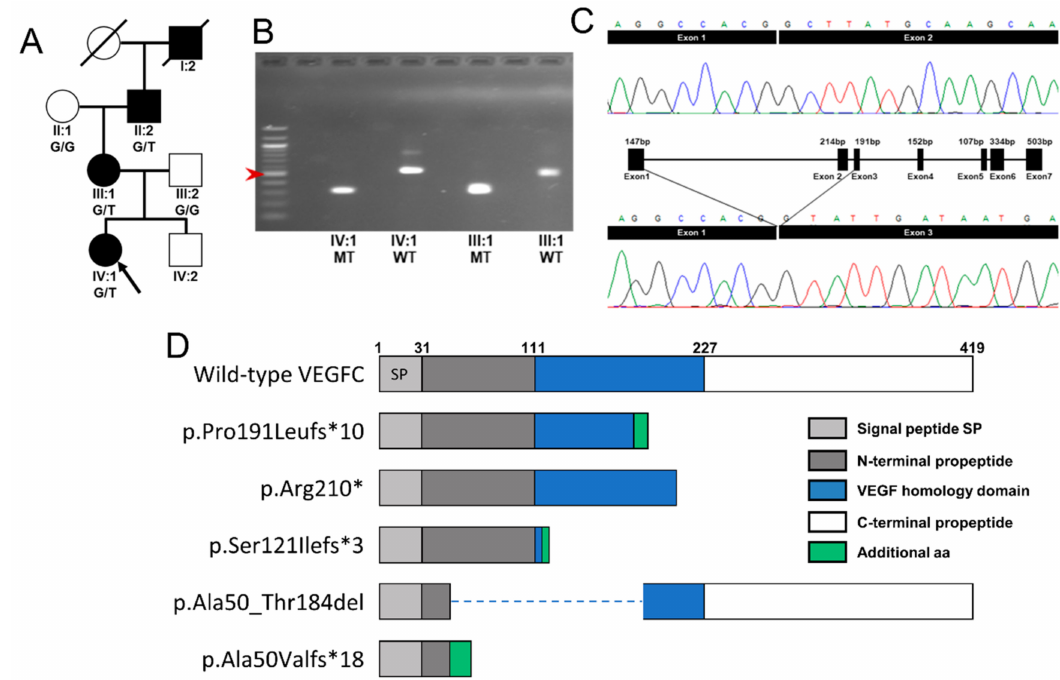
Figure 2. Genetic analysis of the family. ( A ) Pedigree of the family. Filled symbols denote affected individuals. Arrow indicates the proband. For individuals where DNA has been Sanger sequenced, the genotype is indicated. ( B , C ) After RT-PCR of RNA extracted from blood from the proband (IV:1) and her mother (III:1), cDNA amplification of a VEGFC fragment gave dual bands. The DNA from the bands was extracted from the gel and sequenced. ( B ) Agarose gel showing the successful separation of the wild type (WT; 489 bp) and mutant band (MT; 275 bp). Left lane: 100 bp ladder with 500 bp band is indicated with an arrow. ( C ) Electropherograms showing the VEGFC sequence of the products from ( B ) wild type allele (top panel) and mutant allele (bottom panel). The mutant allele highlights the skipping of exon 2 by displaying the sequence from the end of exon 1 and the beginning of exon 3. ( D ) Schematic representation of the wild type VEGFC protein domains (top) and the structures of the predicted mutant VEGFC proteins for the four previously published VEGFC mutations. The bottom panel shows the predicted mutant VEGFC protein described as the p.Ala50Valfs*18 identified in this family, lacking the C-terminal propeptide, the VHD, and most of the N-terminal propeptide. The additional 18 amino acids added to the sequence as a consequence of the frameshift are represented in